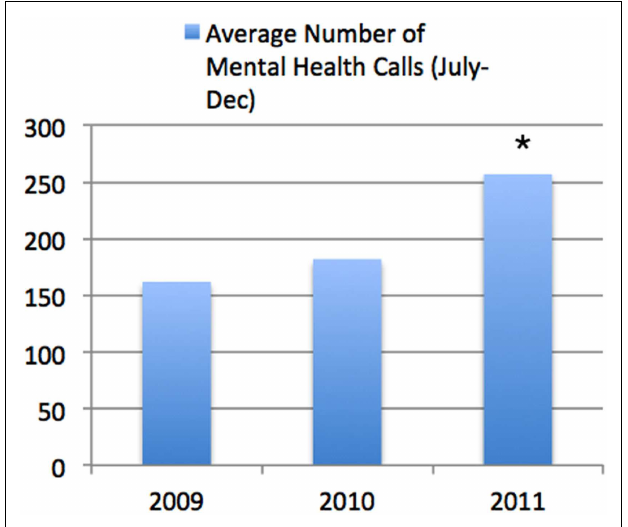
FIGURE 4 |Average Number of Mental Health Calls (July–December). This shows the information across all of the Edmonton Police Force. It can be seen that there was a highly significant increase in the number of calls identified as being due to mental health issues between the same time period in 2010 compared to 2011 (* p < 0.001).